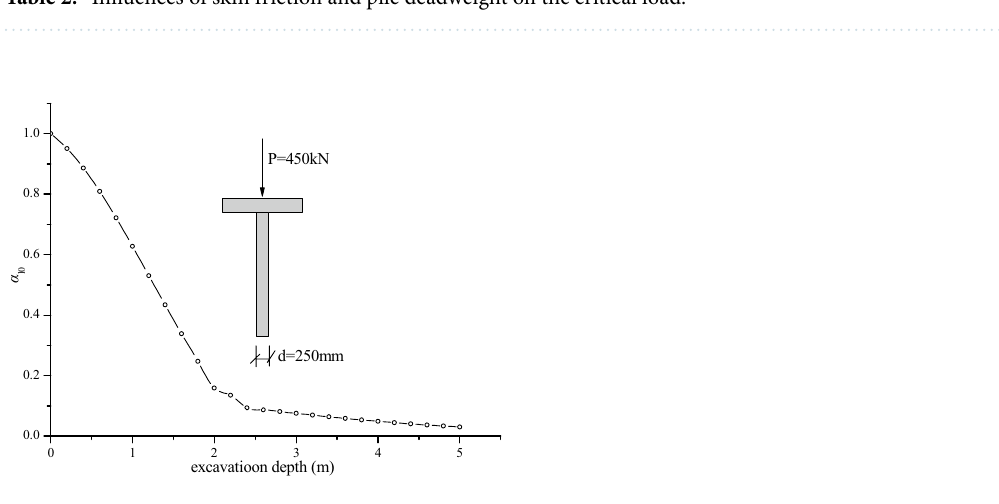
Figure 7. Impact of excavation depth on the critical